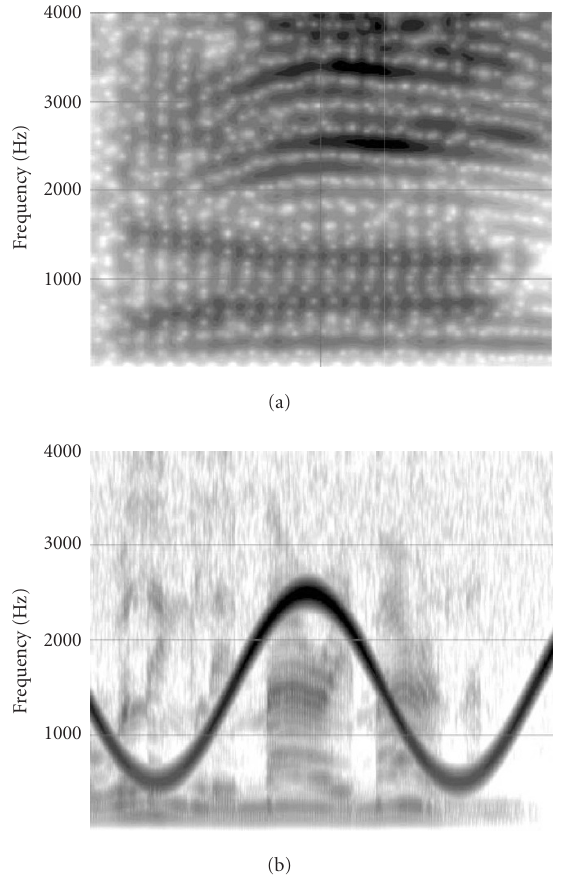
Figure 6: (a) The spectrogram of the extracted /di/. (b) The spec- trogram of the extracted